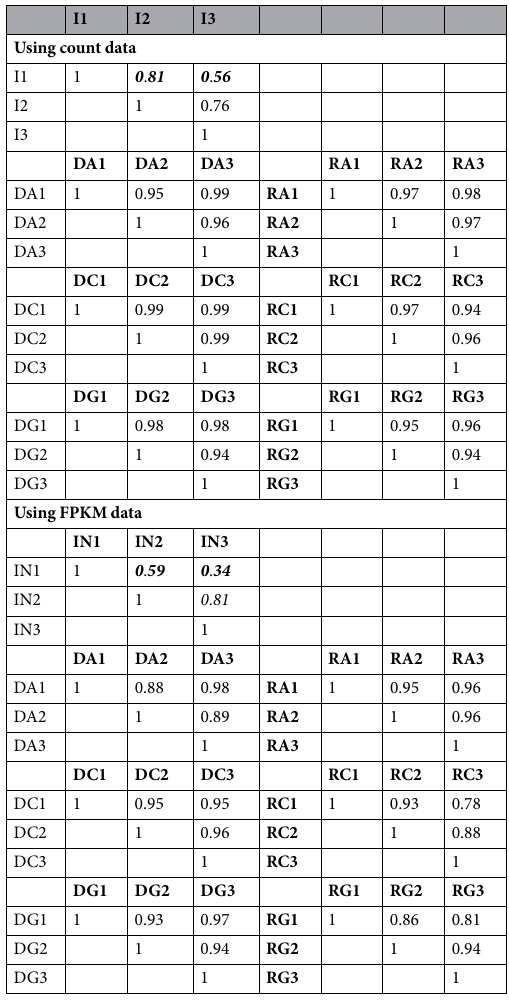
Table 3. Pearson correlation coefficients between the biological